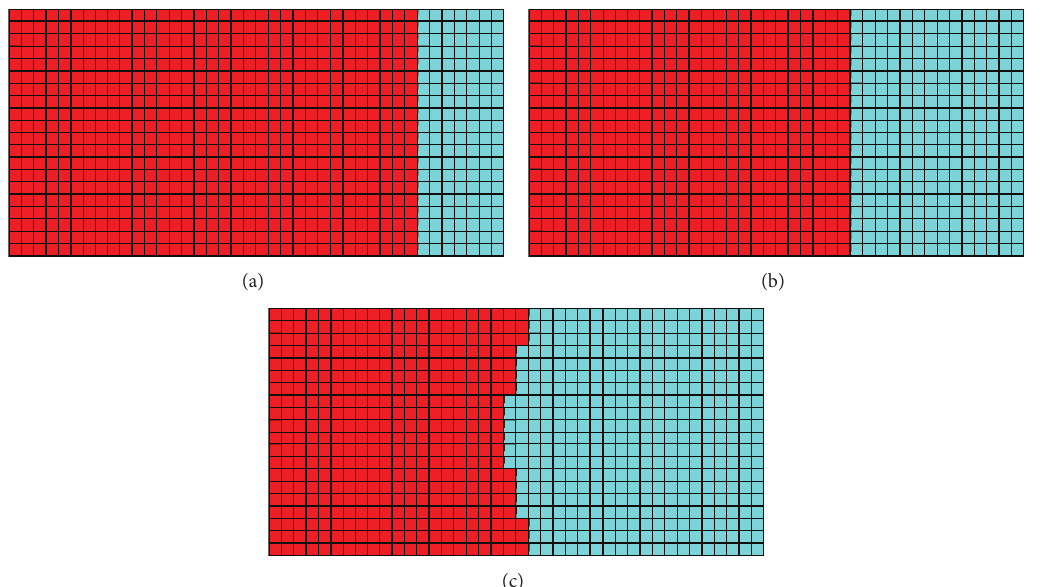
Figure 4: Topology evolving process using conventional sensitivity analysis. (a) Iteration 7 (rejection ratio 17.5%). (b) Iteration 14 (rejection